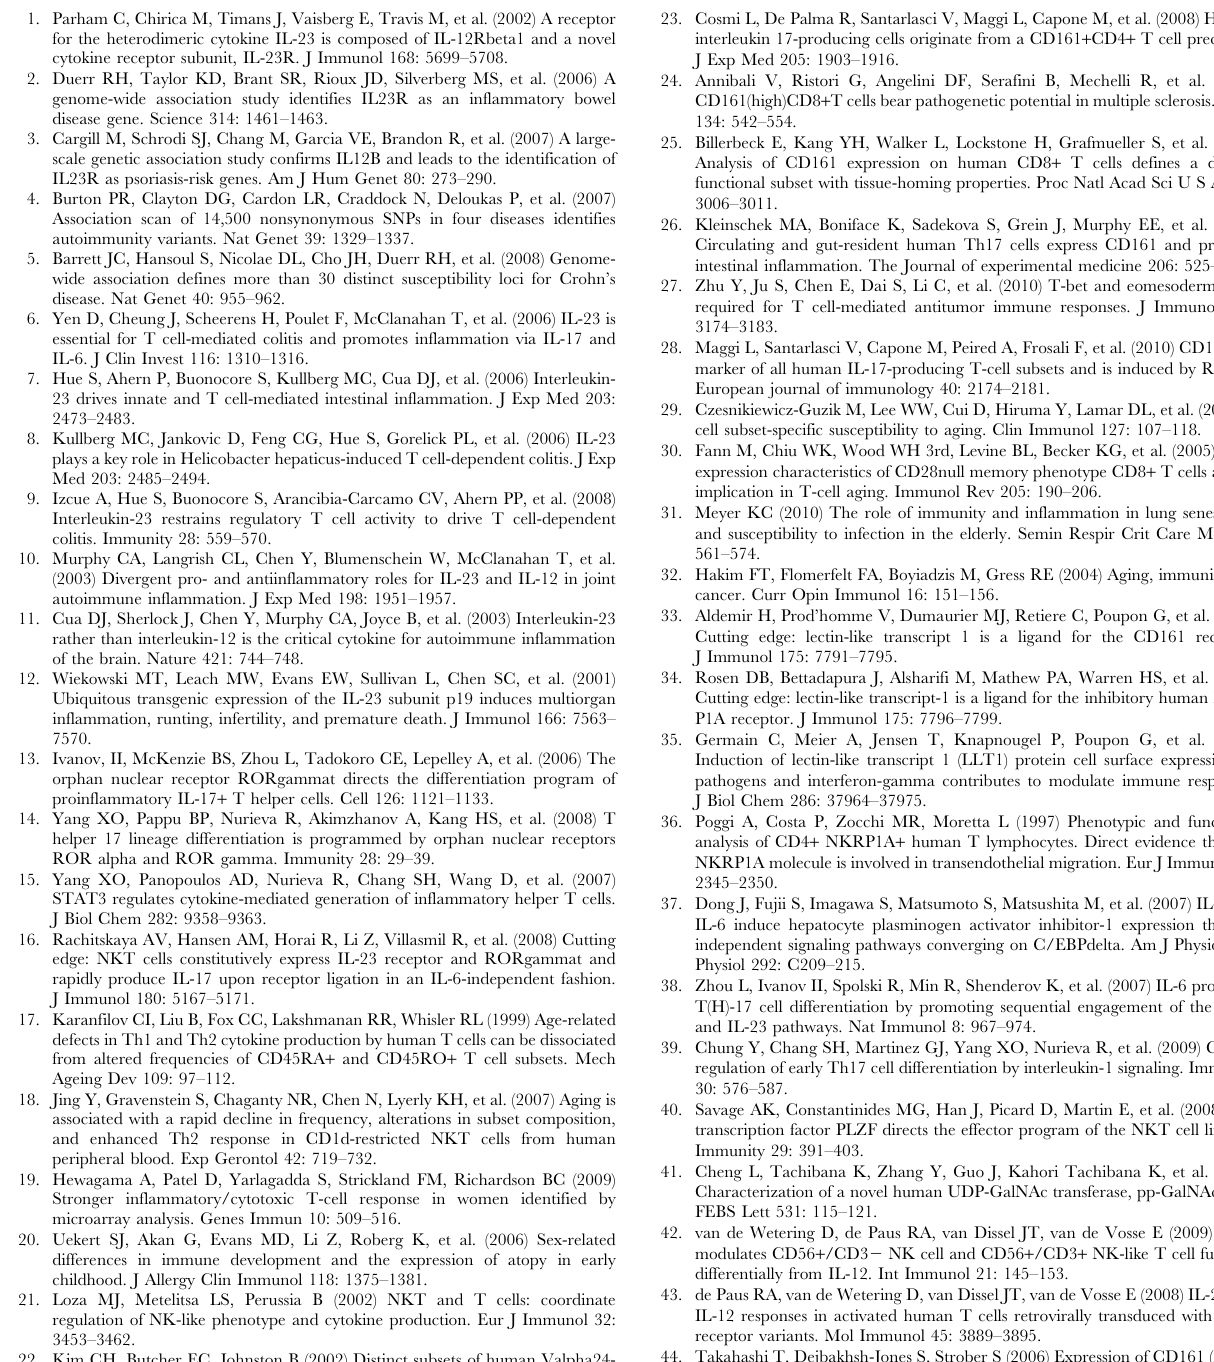
Table S2 Genes differentially expressed between IL-23-respon- sive and non-responsive subjects.